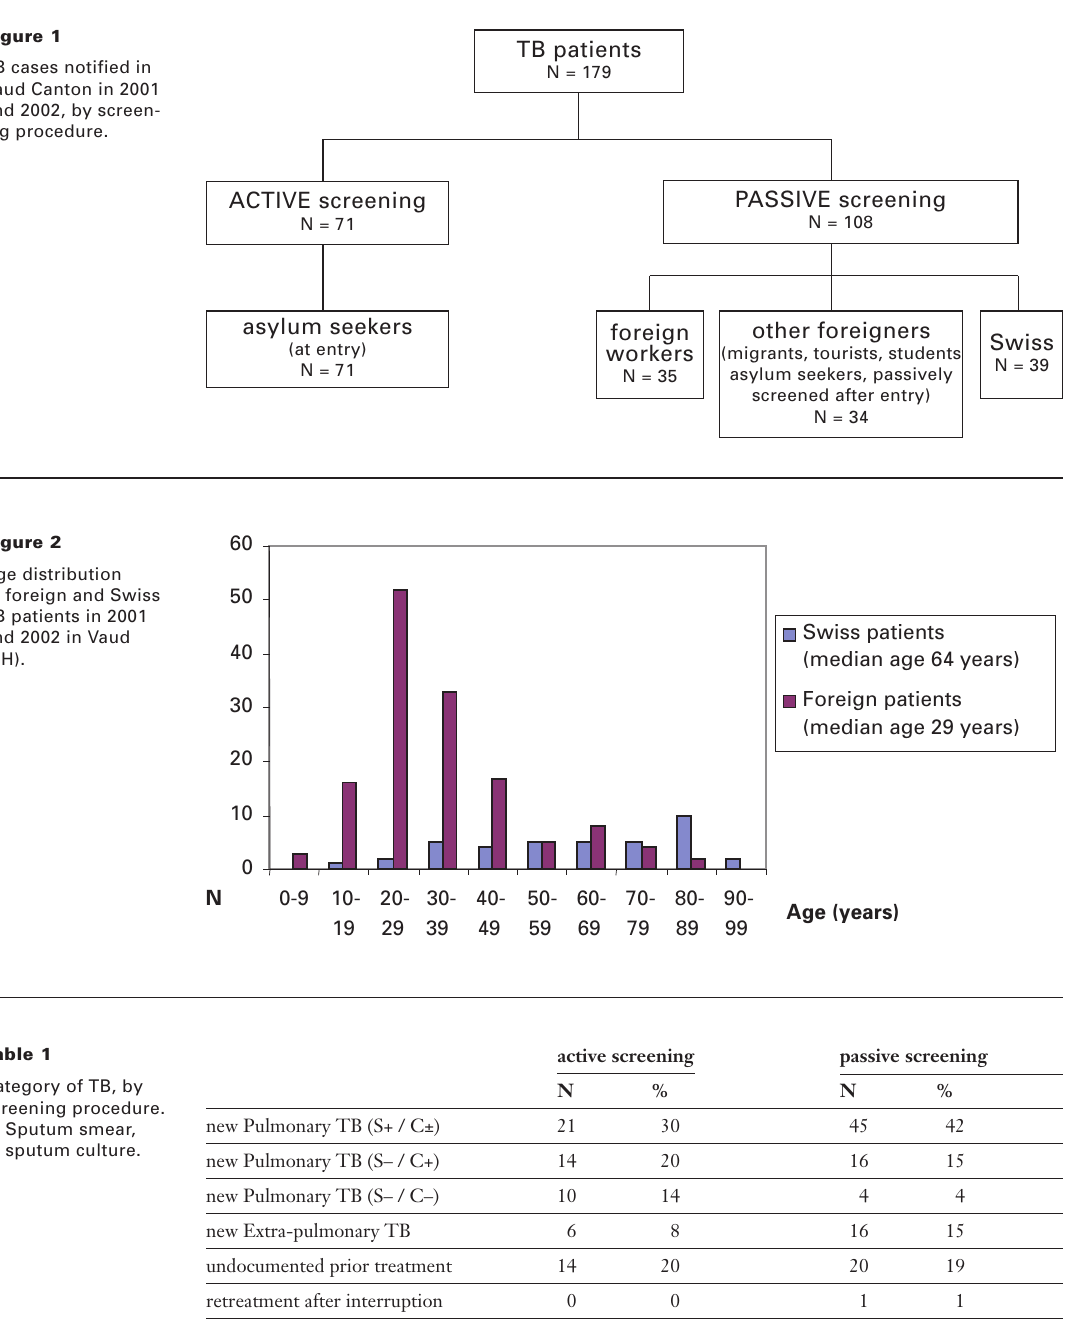
TB cases notified in Vaud Canton in 2001 and 2002, by screen- ing procedure.